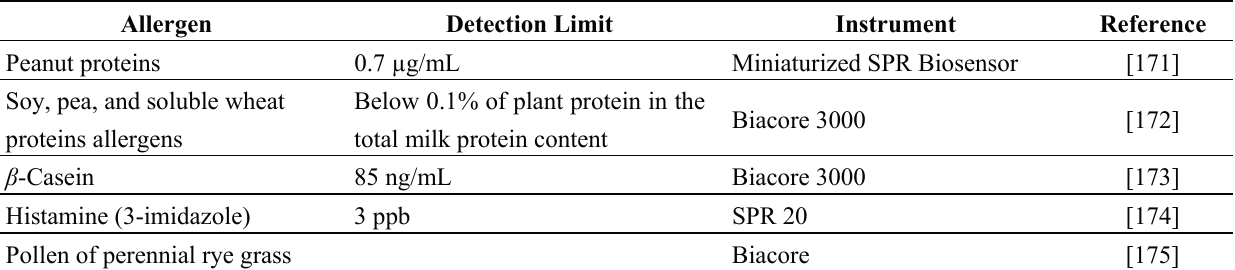
Table 8. Detection of allergen by SPR biosensors.